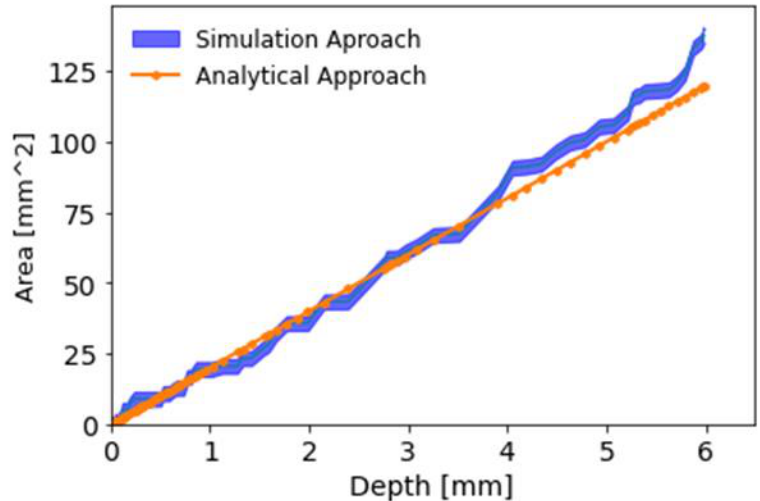
Figure 4. Comparison between the calculated contact area from the analytical and FE model.